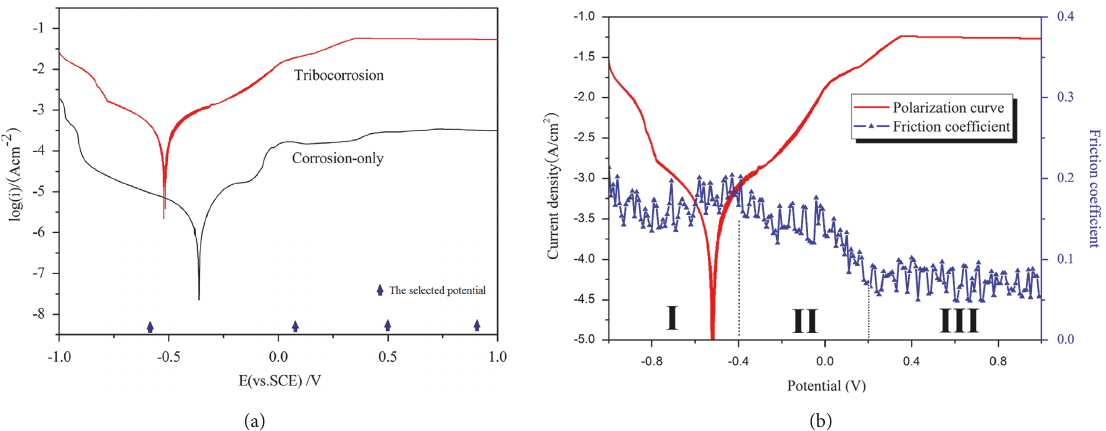
Figure 2: (a) Polarization curves of a Monel K500 alloy in artificial seawater obtained in corrosion-only and tribocorrosion conditions. (b) Polarization curve of Monel K500 alloy in artificial seawater and evolution of coefficient of friction obtained during measuring. The corrosion potential under tribocorrosion conditions is shifted to more cathodic potentials, and the corrosion current density increases by two orders of magnitude. The coefficient of friction decreases with higher anodic potentials as a consequence of the presence of oxide film on the surface [29].